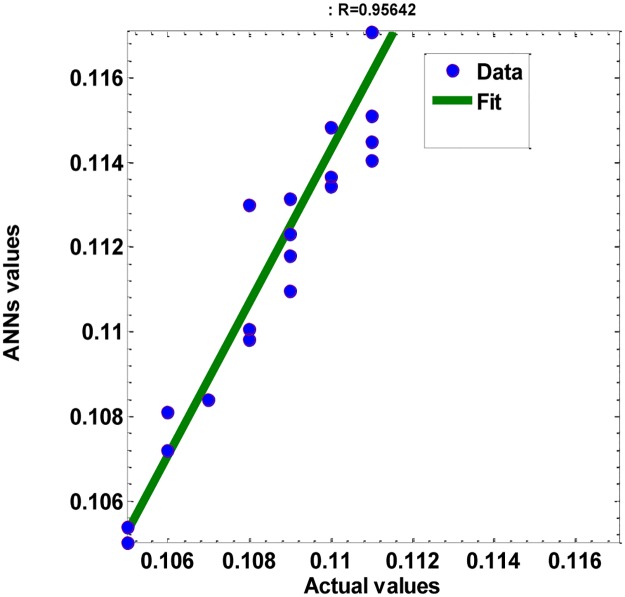
scatter plot of the testing data with the corresponding of the ANN’ model results, with (R = 0.96, and SSE = 4.68E-04).